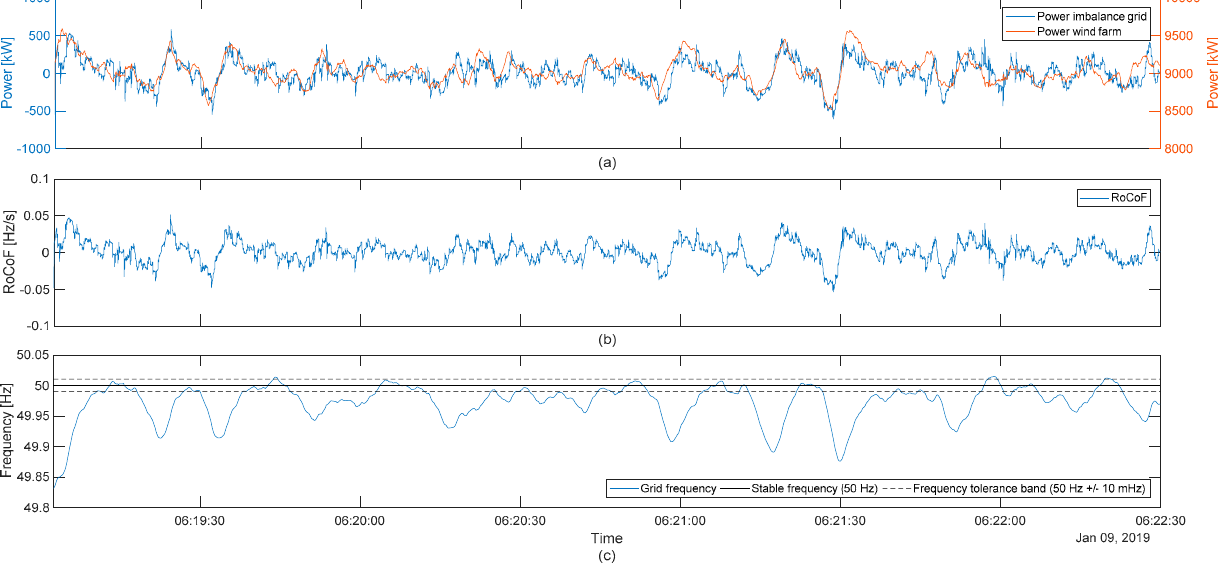
Figure 15. Results of scenario III: Wind farm power (pu base = 10 MW), PFC modification factor η PFC , and grid frequency during negative wind gusts. 4. Discussion The results show that WTs would have been able to support the grid to some extent. The provision of SI could have lowered the RoCoF below a critical threshold within mil ‐ liseconds and thus have lowered the consequences for the conventional power station. However, as the frequency rises too fast above the 51.5 Hz threshold, it would not have been possible to keep the gas ‐ fired gen ‐ set (Generator 12) connected to the grid. The grid could have been stabilized if the number of WTs were increased to ten and the WTs would provide PFC in addition to SI. In this case, the WTs would have been able to balance the power in the grid effectively and limit the frequency to 50.8 Hz. Keeping Generator 12 06:20:45